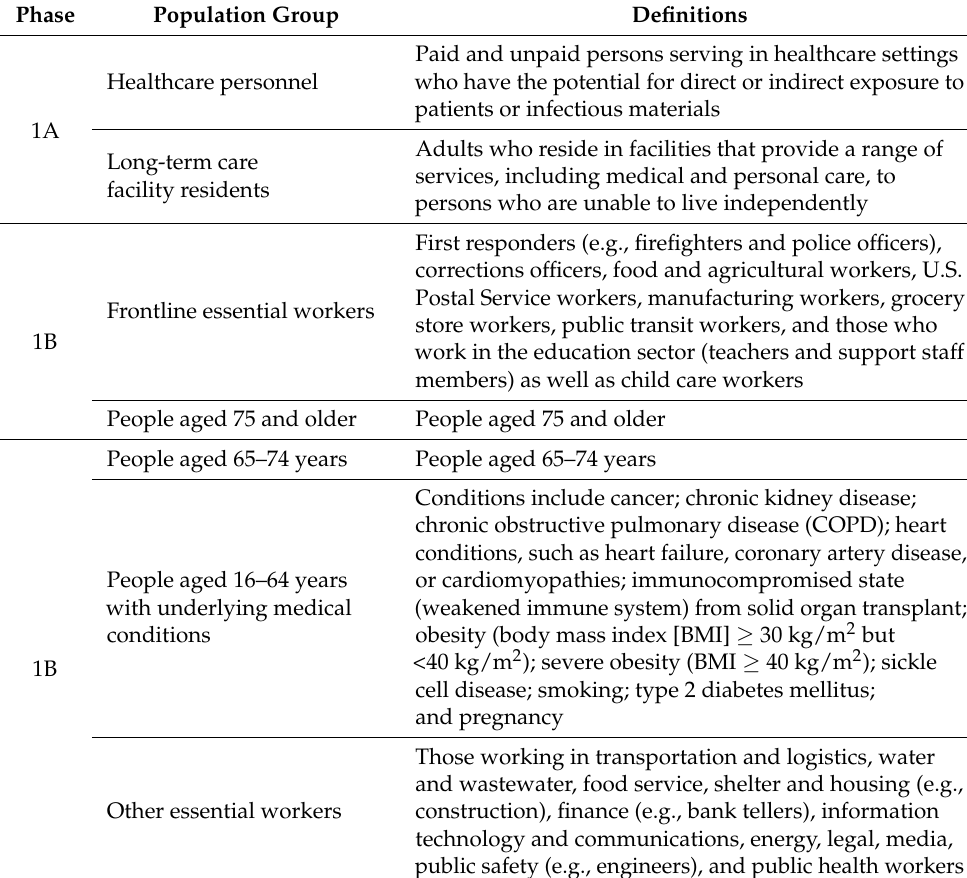
Table 1. Centers for Disease Control and Prevention (CDC) guidance summary and